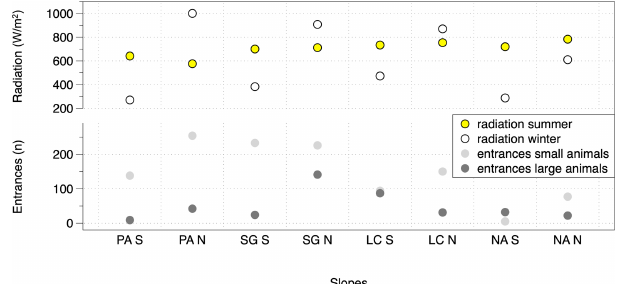
Figure 8. Calculated solar radiation and sum of animal burrow en- trances separated per animal group (large and small animals) for the slopes along the studied climate gradient; the solar radiation calcu- lation follows Bendix (2004); the slopes are oriented N(orth)-facing and S(outh)-facing; the depicted data are pooled from all three field campaigns: 2016, 2017 and 2018. PA – Pan de Azúcar, SG – Santa Gracia, LC – La Campana, NA – Nahuelbuta. (Note that in PA the sum of the south-facing plot entrances is one plot, and the north- facing entrance sum is three